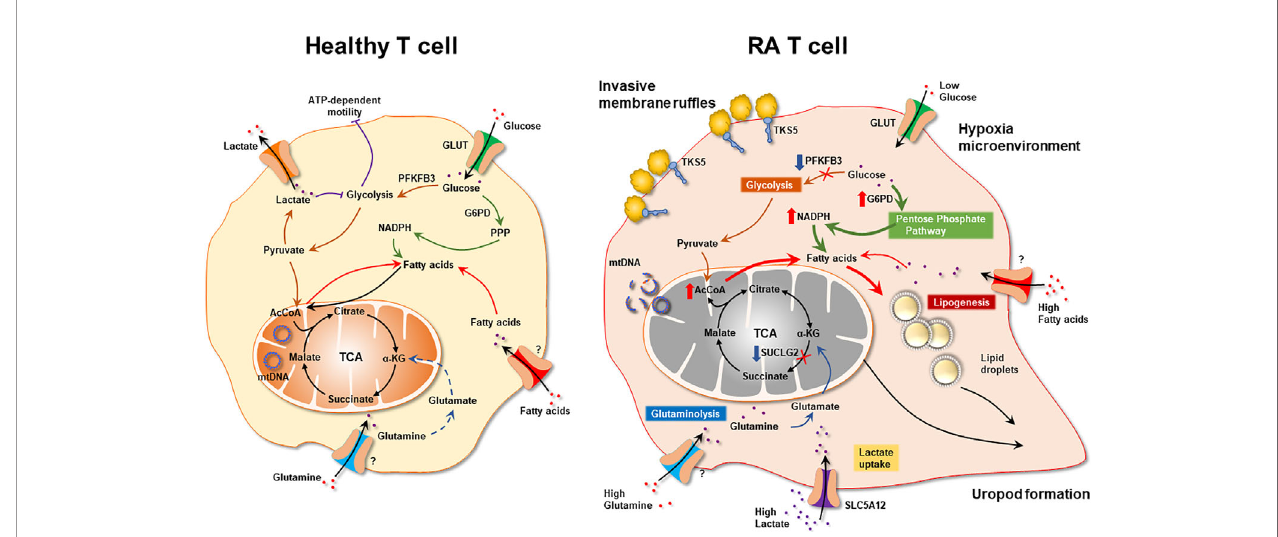
FIGURE 5 | The Metabolic Signature of Autoreactive T cells in Rheumatoid Arthritis. Schematic diagram of metabolic pathways in health and RA T cells. Healthy T cell: Low-proliferating healthy T cells (naïve, memory) rely on mitochondrial energy production. When differentiating into highly replicating effector T cells, bioenergetic and biosynthetic needs are ful fi lled by engaging glycolysis. RA T cells: Biased toward biomass generation, RA T cells shunt glucose into the pentose phosphate pathway and produce NADPH. Mitochondria with unrepaired mtDNA utilize relatively low amounts of oxygen and produce low concentrations of ROS. Mitochondrial succinate production is suppressed due to low activity of Succinate-CoA ligase and a-ketoglutarate is converted into citrate. Exported citrate supplies cytoplasmic acetyl-CoA pools and promotes lipogenesis. Surplus lipids sustain the generation of invasive membrane ruf fl es and of cellular uropods. With low ATP production, RA T cells require external energy sources, such as glutamine and lactate to meet basic bioenergetic needs. By diverting energy away from ATP production toward assembly of biosynthetic precursor molecules, RA T nourish the emergence and the survival of replicating effector T cells that are tissue-invasive and pro- in fl ammatory. a -KG, a -ketoglutarate; mtDNA, mitochondrial